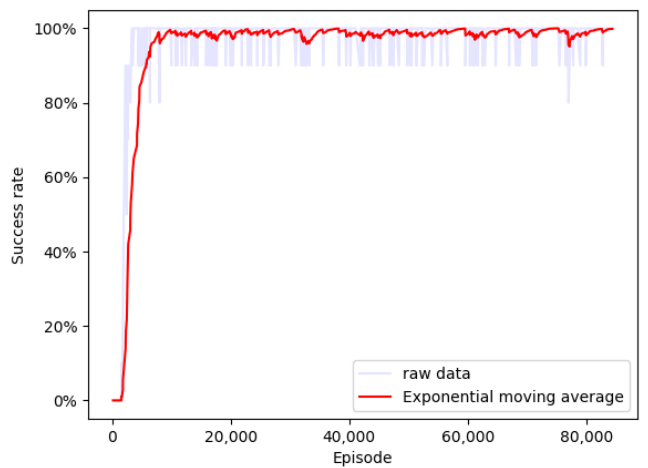
Figure 10. Comparison of reward.